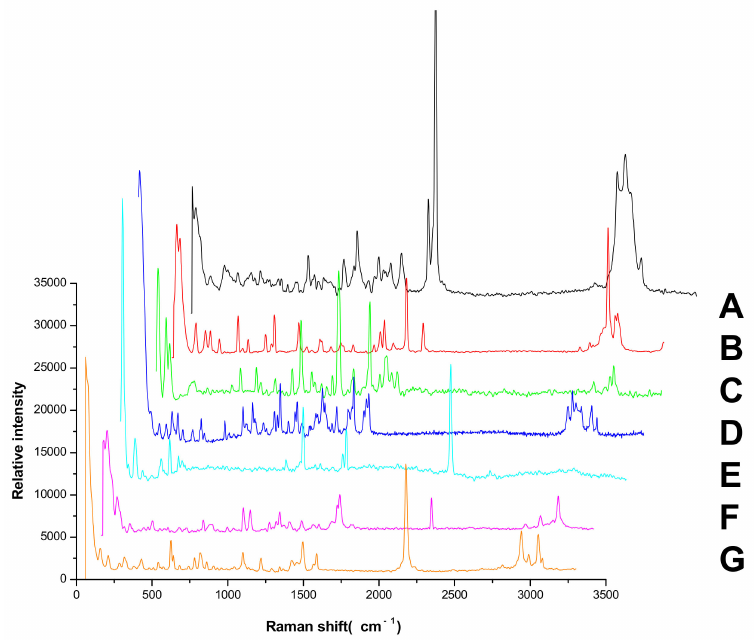
Figure 3. The Raman spectra of seven pesticide reference powders. (A, B, C, D, E, F, and